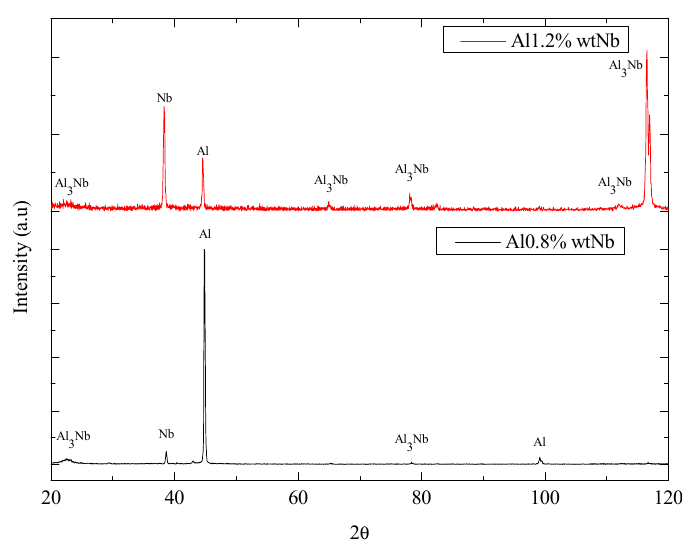
Figure 16. X-ray di ff raction (XRD) of the alloys Al–0.8 Nb and Al–1.2 Nb Figure 16. X-ray diffraction (XRD) of the alloys Al–0.8 Nb and Al–1.2 Nb (wt.%).